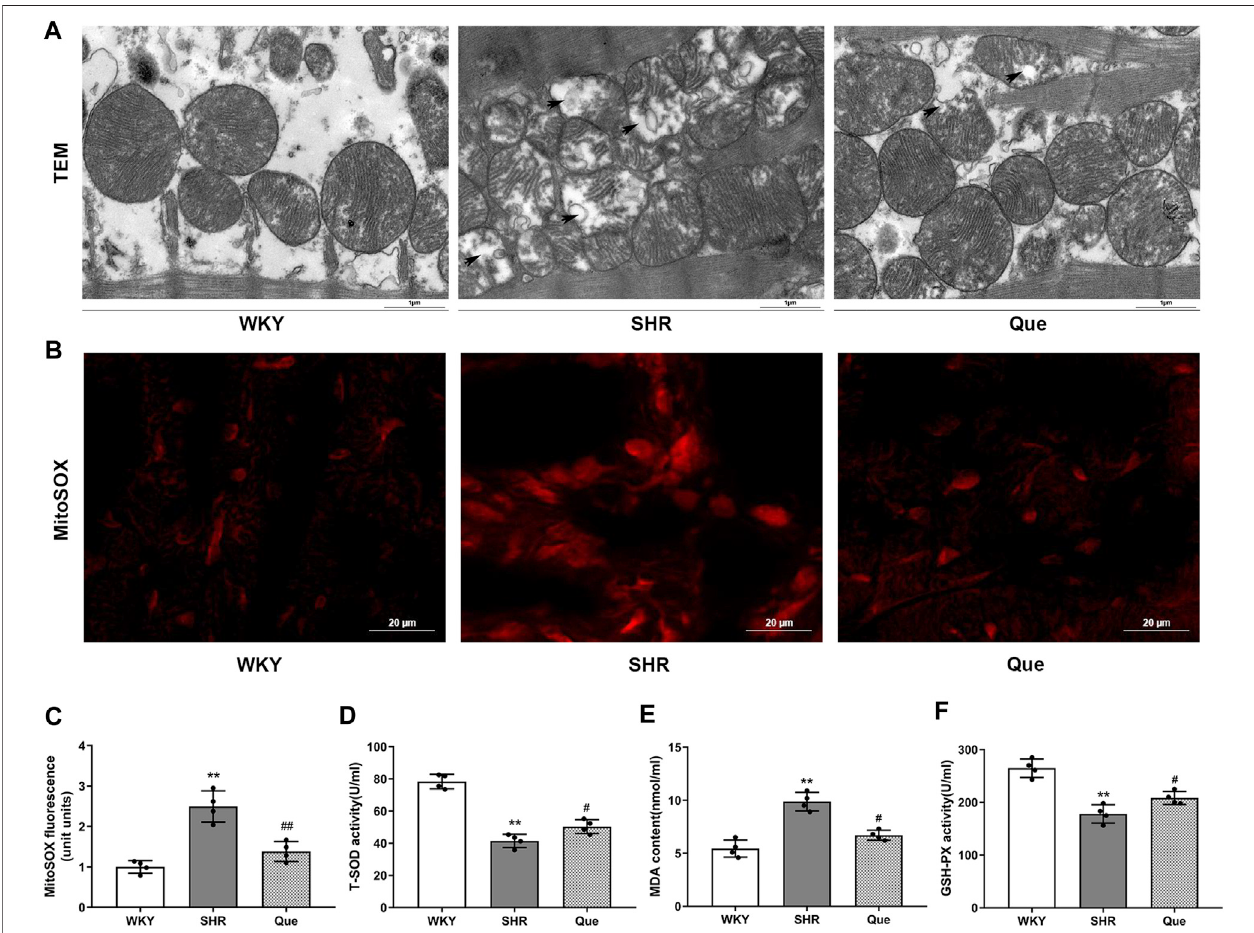
FIGURE 3 | Quercetin improves mitochondrial structure and inhibits oxidative stress in SHRs. ( A) Representative transmission electron microscopy (TEM) images of mitochondria in hearts from WKY rats and SHRs. Scale bar (cid:1) 1 μ m. (B) Representative microphotographs of MitoSOX staining in hearts from WKY rats and SHRs. Scale bar (cid:1) 20 μ m. (C) Quantitative analysis of the relative levels of mitochondrial superoxide in hearts from WKY rats and SHRs (n (cid:1) 4). (D – F) Quanti fi cation of Total Superoxide dismutase (T-SOD), Malondialdehyde (MDA) and Glutathione peroxidase (GSH-PX) levels (n (cid:1) 4). Data are mean ± SD. * p < 0.05, ** p < 0.01 vs WKY group; # p < 0.05, ## p < 0.01 vs SHR